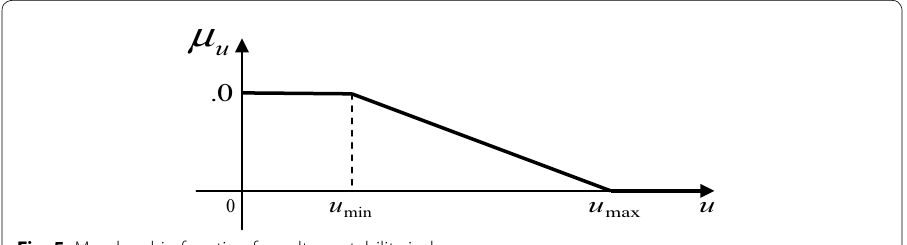
Fig. 5 Membership function for voltage stability